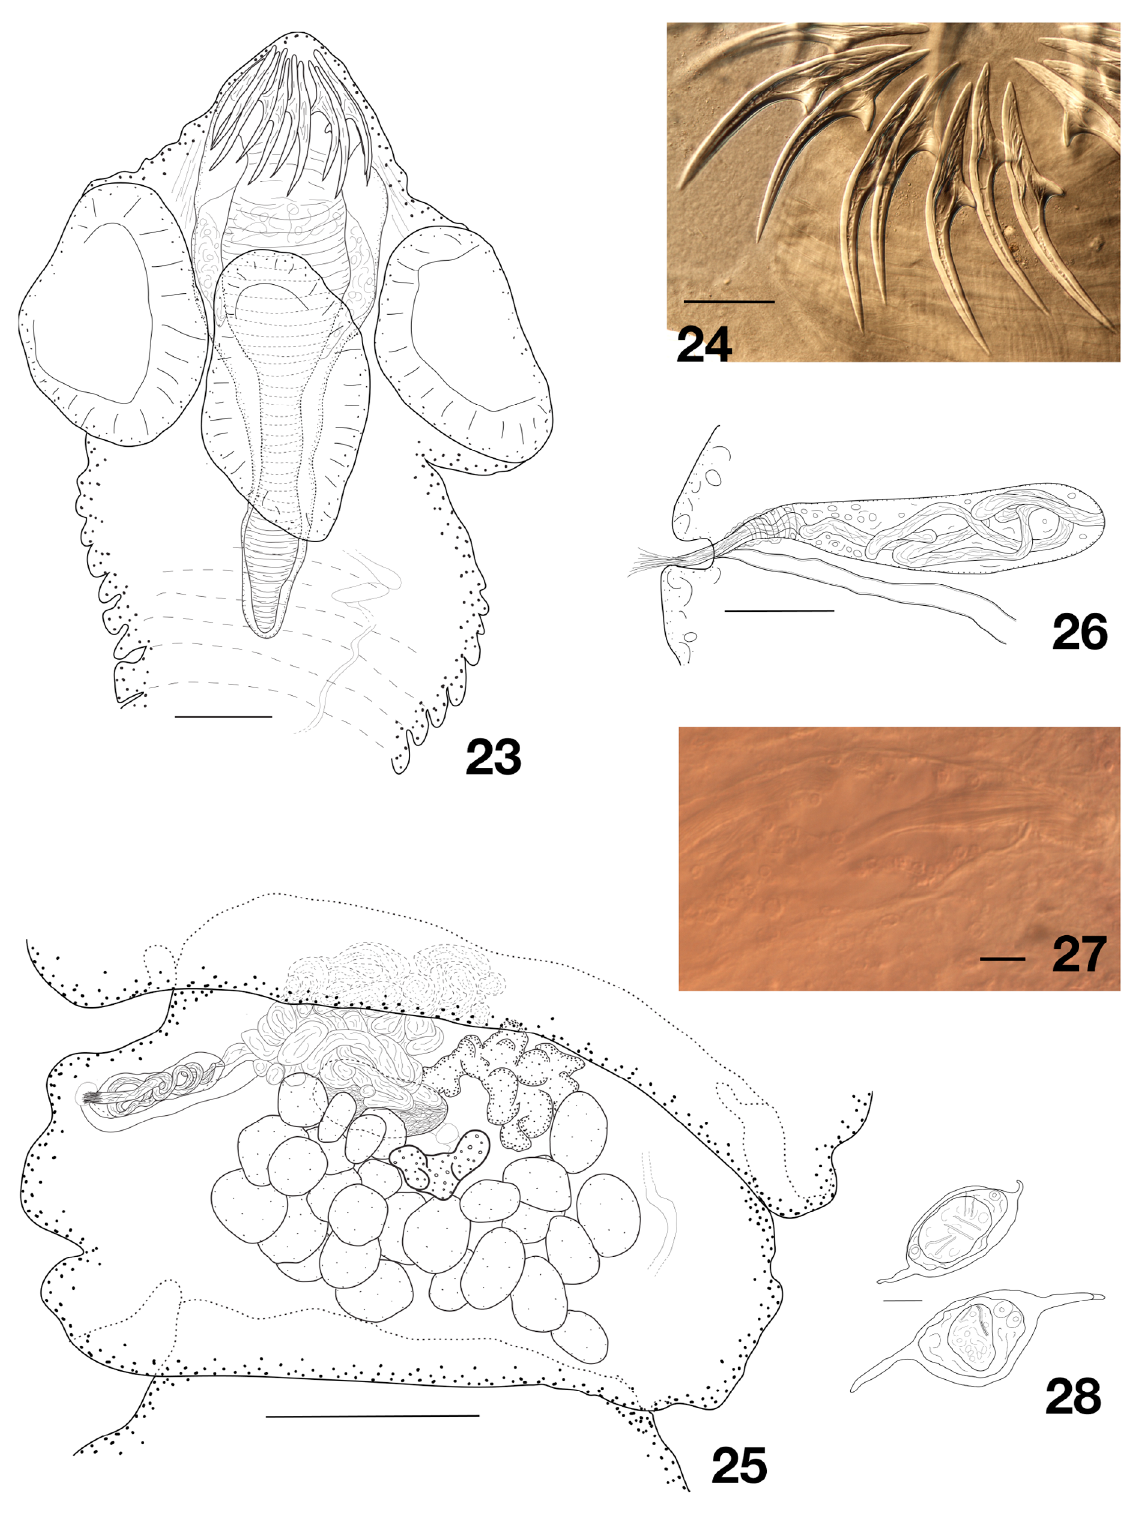
Figs 23–28. Dictymetra longiuncinata sp. nov. 23 . Scolex. 24 . Hooks. 25 . Mature proglottis. 26 . Terminal genitalia. 27 . Cirrus armament. 28 . Eggs. Scale bars: 23 = 100 µm; 24, 26 = 50 µm; 25 = 200 µm; 27 = 10 µm; 28 = 20